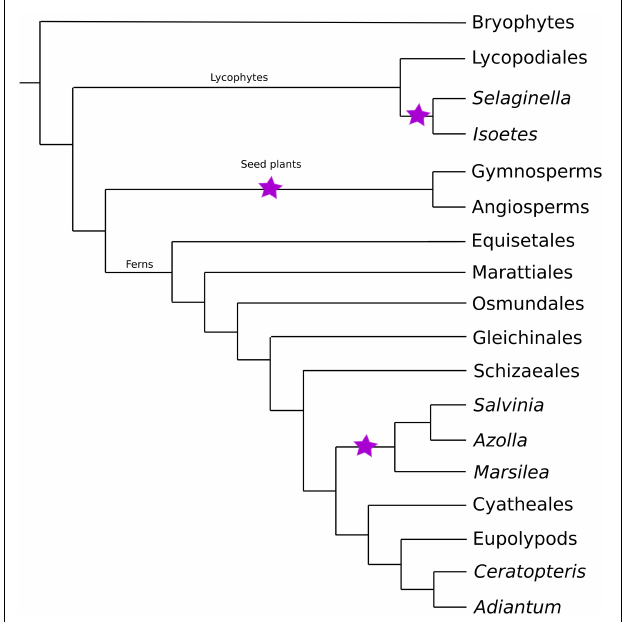
FIGURE 2 | Land plant phylogeny (PPG, 2016). The three major clades of vascular plants (lycophytes, seed plants, and ferns) are shown, along with the three heterosporous lineages denoted with purple stars. Tip labels include phylogenetically important clades as well as clades with current or forthcoming genomic